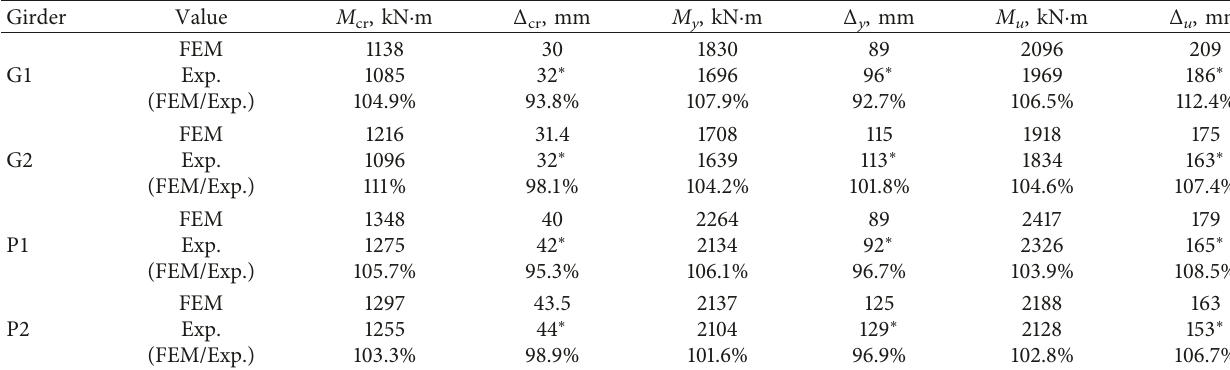
Table 7: Comparison between FEM and experimental